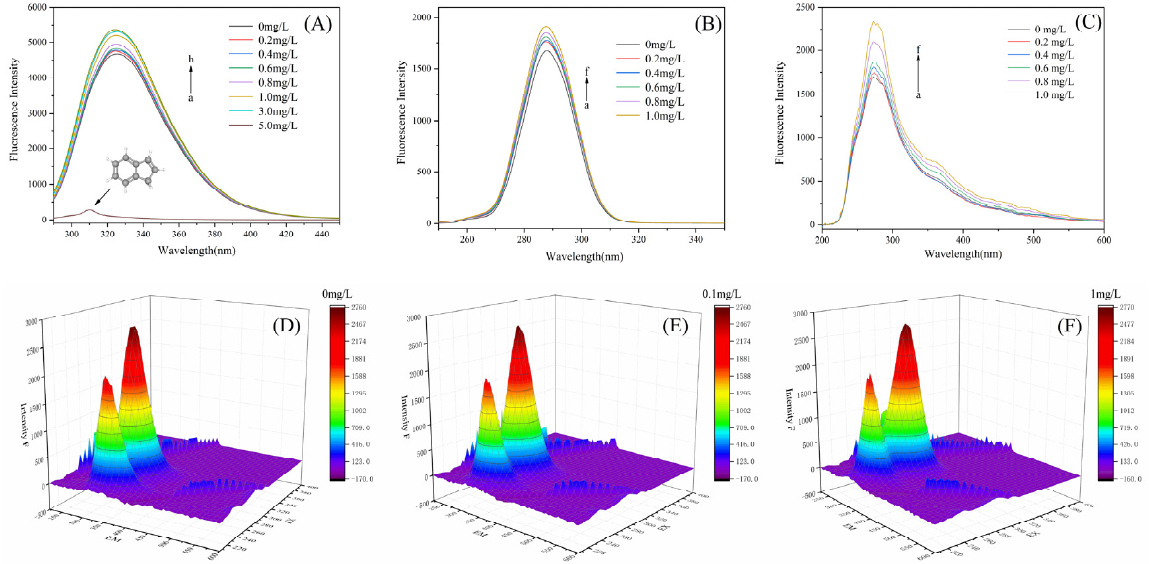
Figure 5. Fluorescence spectra of SOD-IND system. ( A ) Fluorescence spectra; ( B ) Synchronous fluorescence spectrum ( ∆ λ = 15 nm); ( C ) RLS; ( D – F ) EEM Experimental Conditions: T = 298 K, pH = 7.4, λ ex = 280 nm, c (SOD) = 5 µ M, c (IND) of ( A ) a–h: 0, 0.2, 0.4, 0.6, 0.8, 1.0, 3.0, 5.0 mg/L; c (IND) of ( B ) a–f: 0, 0.2, 0.4, 0.6, 0.8, 1.0 mg/L; c (IND) of ( C ) a–f: 0, 0.2, 0.4, 0.6, 0.8, 1.0